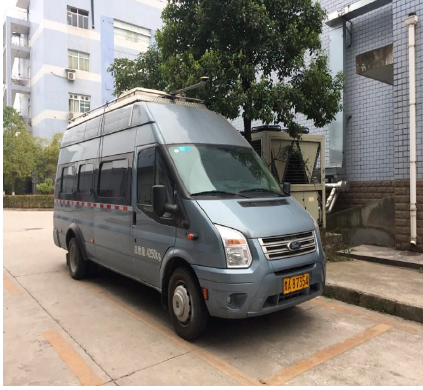
Figure 14. The vehicle used in the navigation experiment.